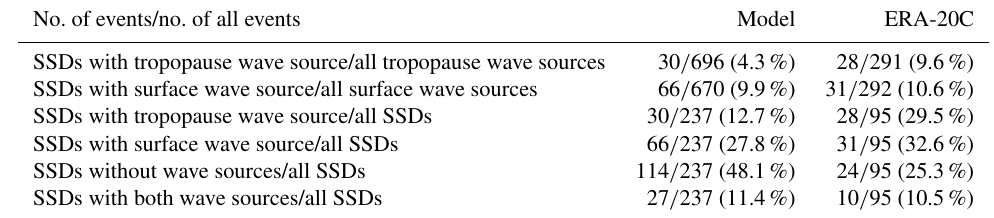
Table 1. Total number of events (and percentage of all events) related to planetary wave sources and SSDs (as labeled). The numbers of events are also listed in Figs. 3, 6, and